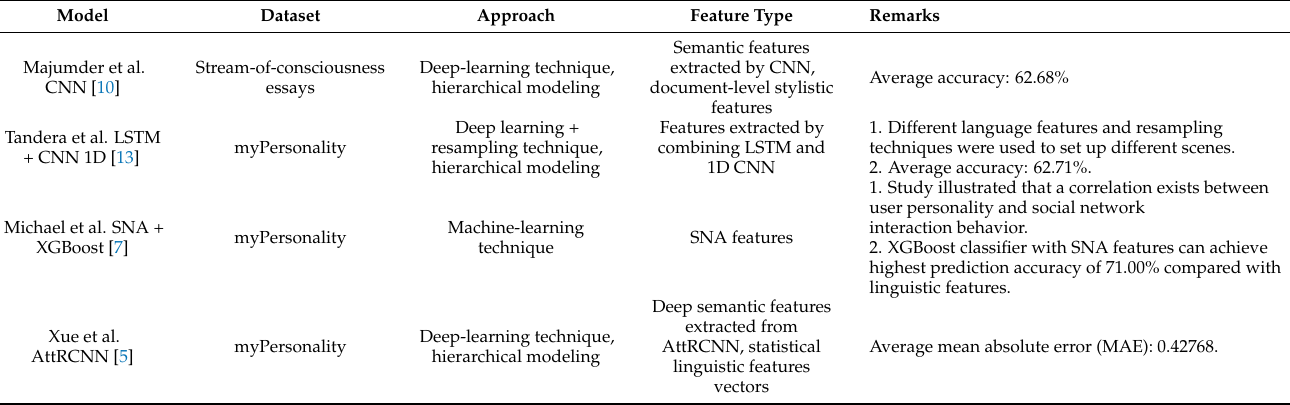
Table 1. Brief description and comparison of important personality-detection models. (Sorted by year of publication).